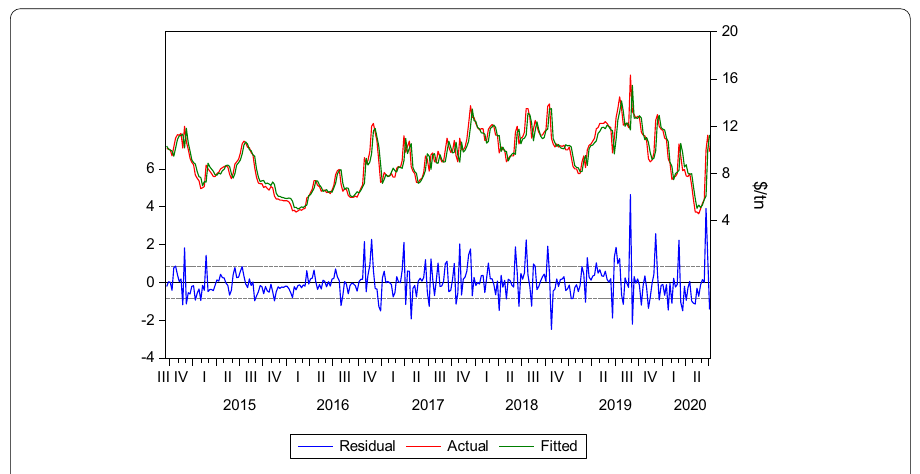
Fig. 3 Baltimore–ARA coal. Source : Elaboration by the authors